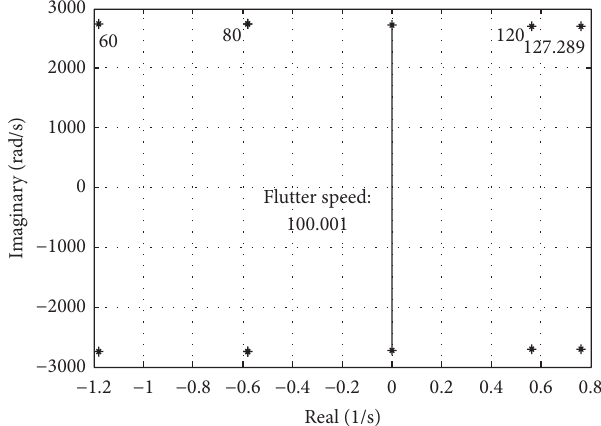
Figure 3: Root locus plot without piezoelectric actuator.